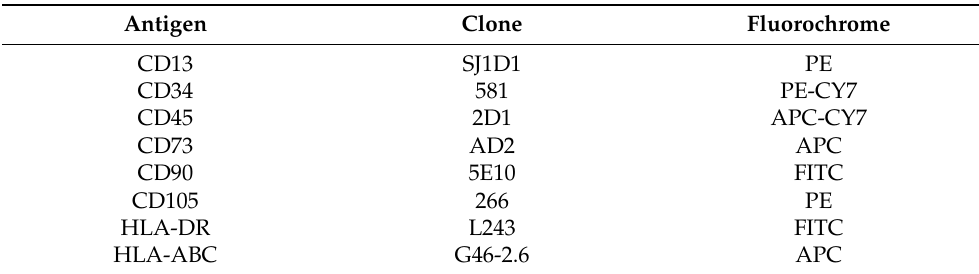
Table 1. Antibodies for flow